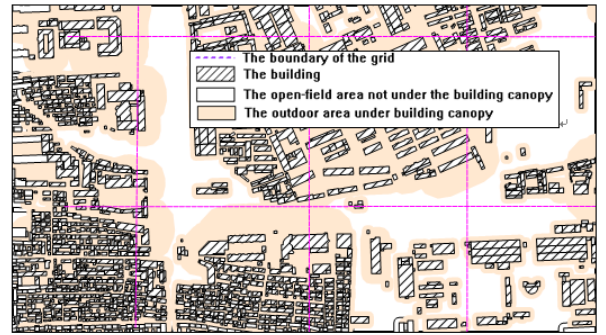
Figure 2. Classification of the buildings, outdoor areas under a building canopy and open-field areas on the land surface and its samples in the grid cells.